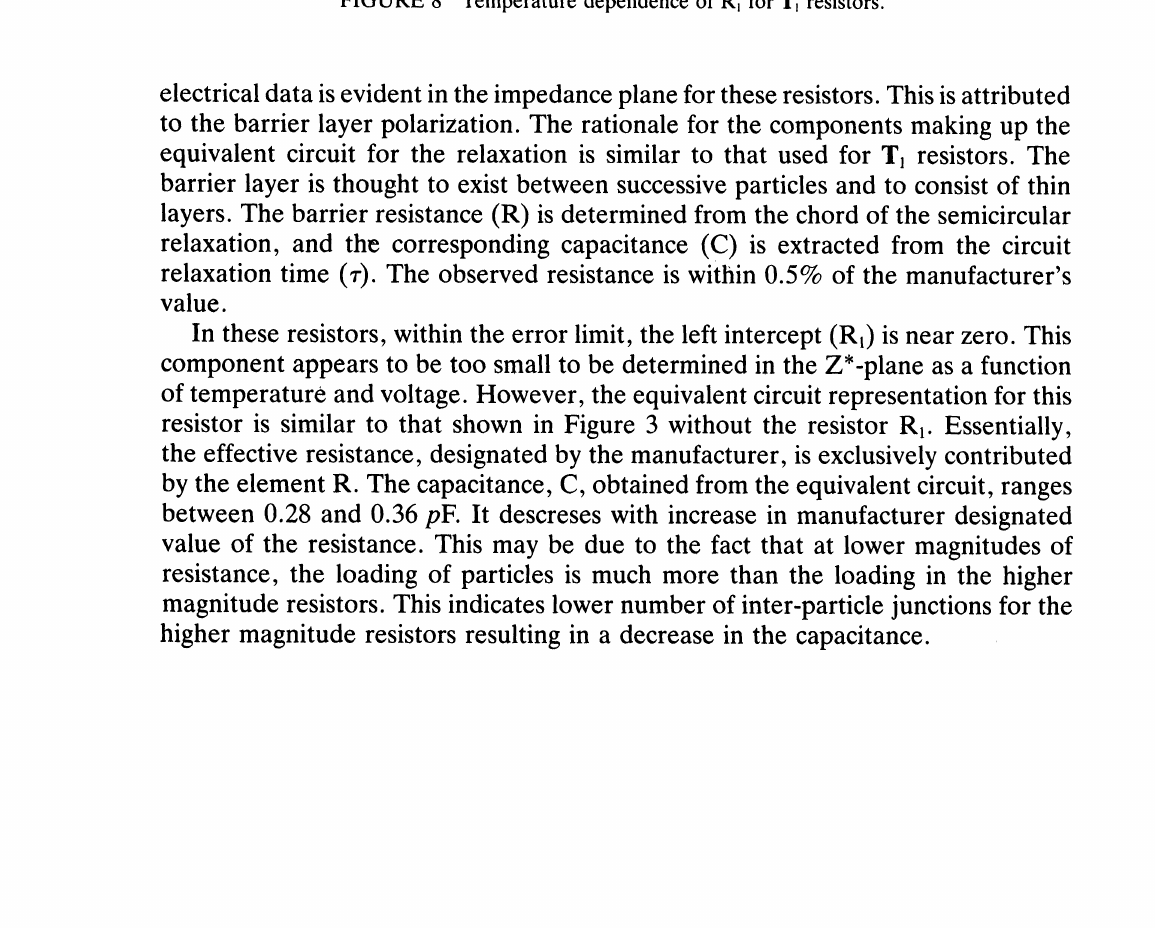
FIGURE 8 Temperature dependence of R for T